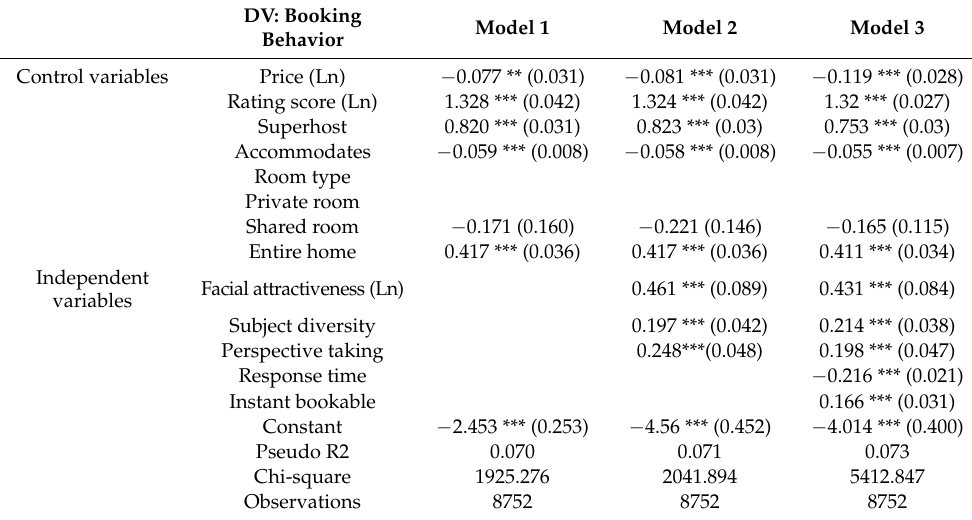
Table 5. Results of the negative binomial regression